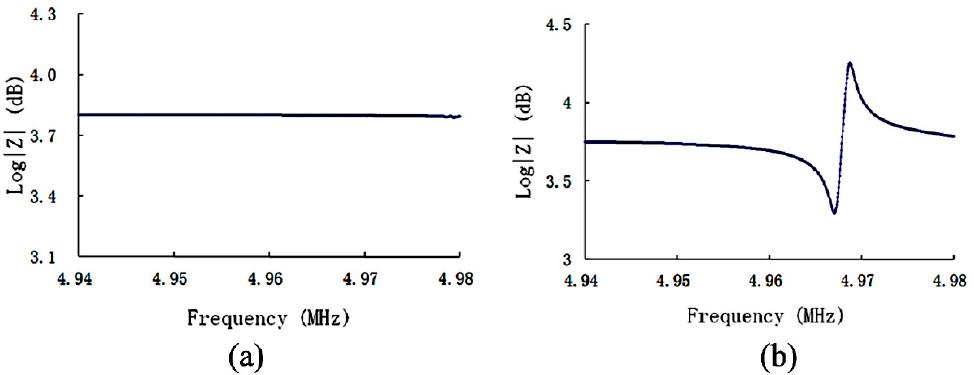
Figure 3. Impedance properties of the (yxl) 13.8° LGT LFE device in different mediums: ( a ) air ( b ) water.